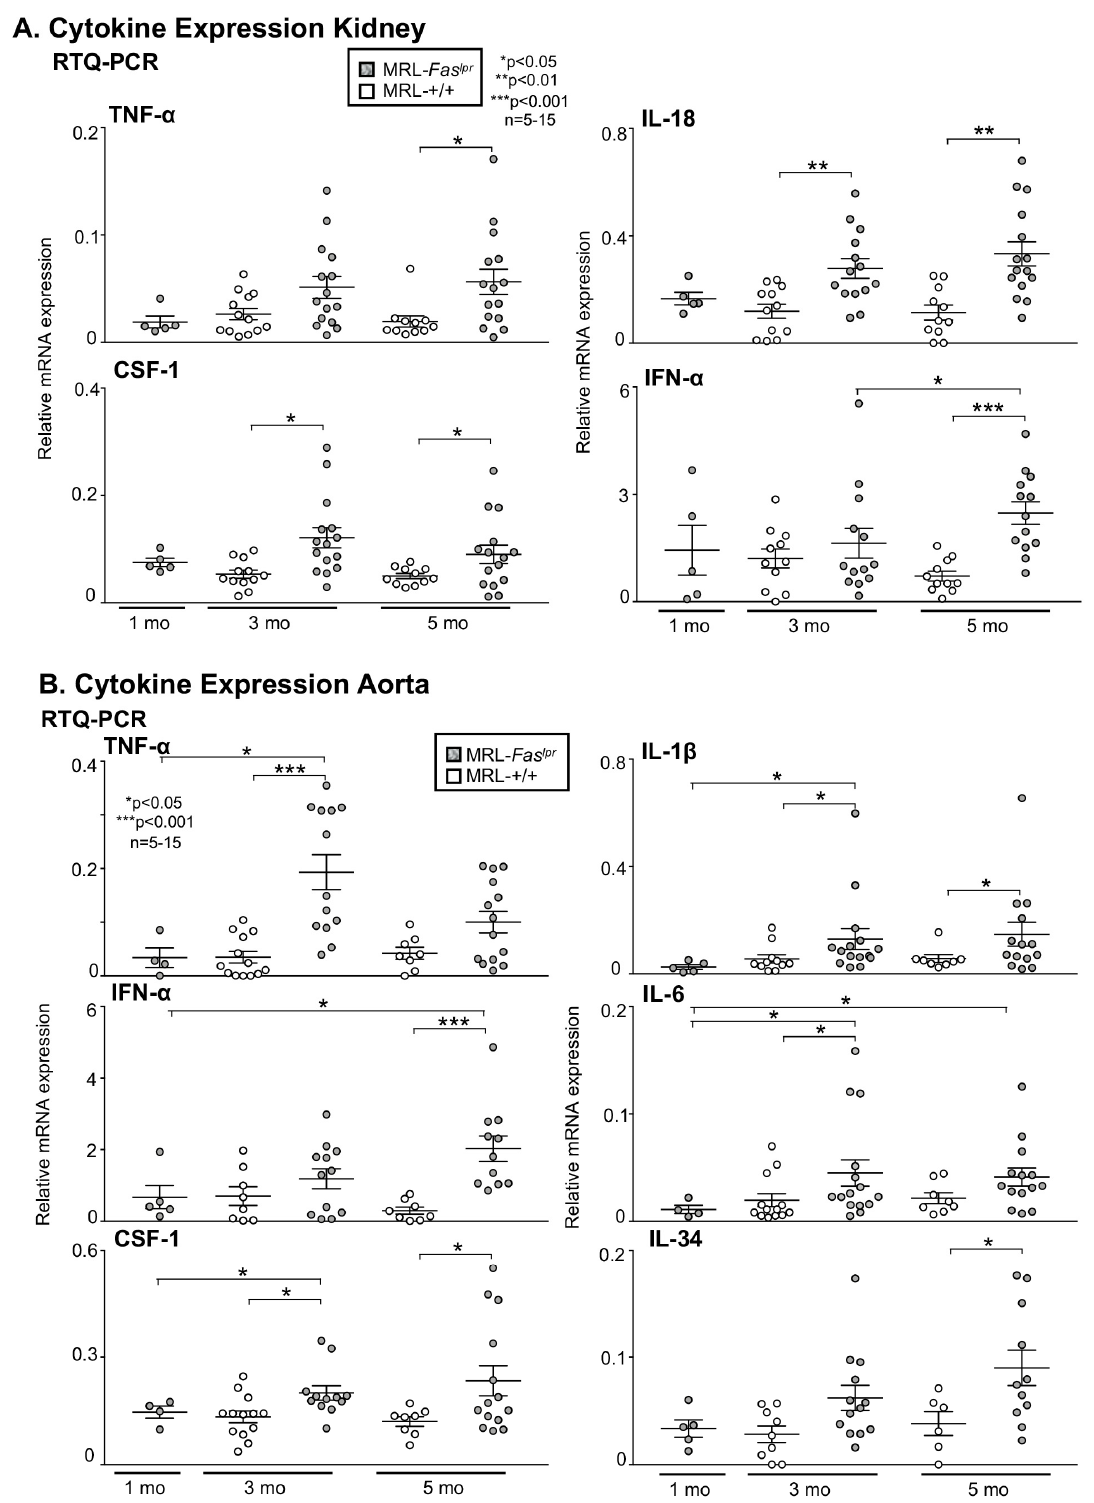
Figure 3. Upregulation of inflammatory cytokines in kidney and aorta with age and in MRL- Fas lpr compared to MRL-++ mice. ( A ) Expression of TNF- α , IL-18, CSF-1, and IFN- α in the kidney of MRL- Fas lpr mice compared to MRL-++ mice at 1, 3, and 5 mo of age. ( B ) Expression of IL-6, TNF- α , IL-1 β , CSF-1, IL-34 and IFN- α in the aorta of MRL- Fas lpr mice compared to MRL-++ mice at 1, 3 and 5 mo of age, n = 5–15 (a single data point refers to a single animal). Values are means ± SEM. Statistical analysis using Mann–Whitney U